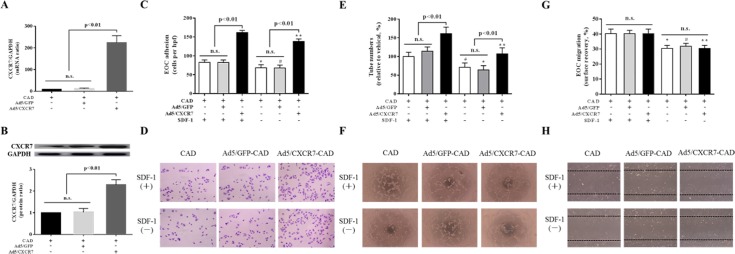
CXCR7 gene transfer enhances the in vitro adhesion function and angiogenesis capacity from CAD patients.Effects of Ad5/CXCR7 gene transfer on in vitro functions of CAD-EOCs. A: Quantitative analyses of CXCR7 mRNA level in EOCs at 48 hours after transduction measured by Real-time PCR. (n = 5 per group). B: Representative photographs and quantitative analyses of CXCR7 protein expression at 48 hours after transduction measured by western blot. Densitometric band analyses are quantified by Image J software and are presented as the relative ratio of CXCR7 to GAPDH. (n = 5 per group). C-D: Quantitative analyses (C) and representative photographs (D) of the adhesion activity of EOCs (*P<0.01, #P<0.01, **P<0.01vs. CAD-EOCs with SDF-1; n = 5 per group). E-F: Quantification analyses (E) and representative photographs (F) of angiogenic function in the Matrigel. (*P<0.01, #P<0.01, **P<0.01 vs. CAD-EOCs with SDF-1; n = 5 per group).G-H: Quantitative analyses (G) and representative photographs (H) of EOC migratory activity of EOCs (*P<0.01, #P<0.01, **P<0.01 vs. CAD-EOCs with SDF-1; n = 5 per group).